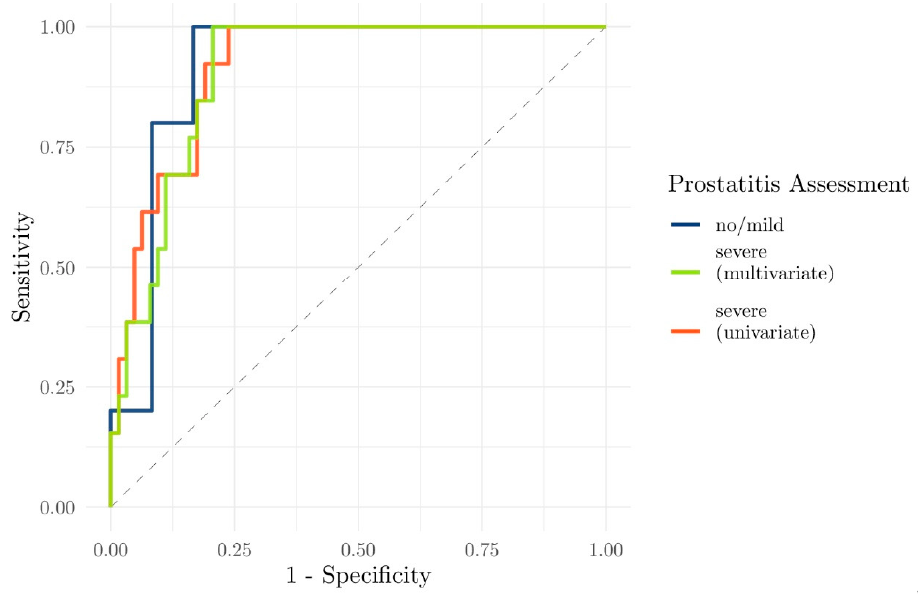
Figure 8. Univariate (ADC mean ) and multivariate (ADC mean , K ep , and PSA density ) receiver operating characteristic (ROC) analysis of clinical and imaging parameters to differentiate csPCa/non-csPCa showing moderate sensitivity/specificity. The univariate (ADC mean = blue) curves for no/mild prostatitis and severe prostatitis were identical, so only one curve was plotted.